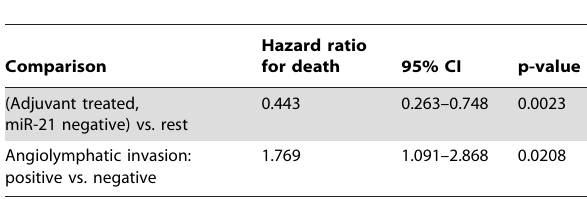
Table 3. Multivariate analysis of all patients: overall survival.